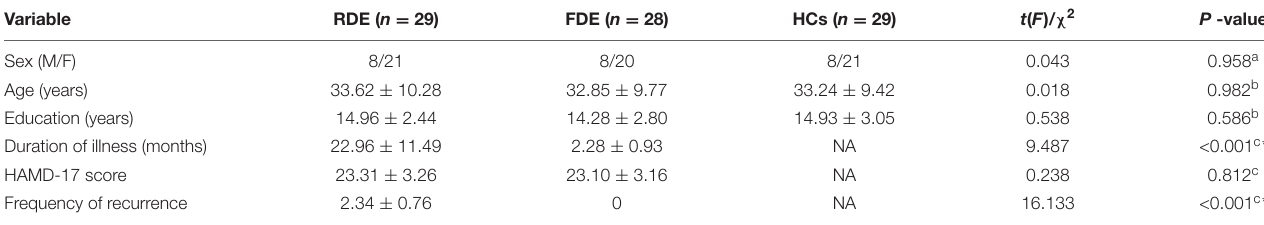
TABLE 1 | Demographic and clinical characteristics of the study participants.